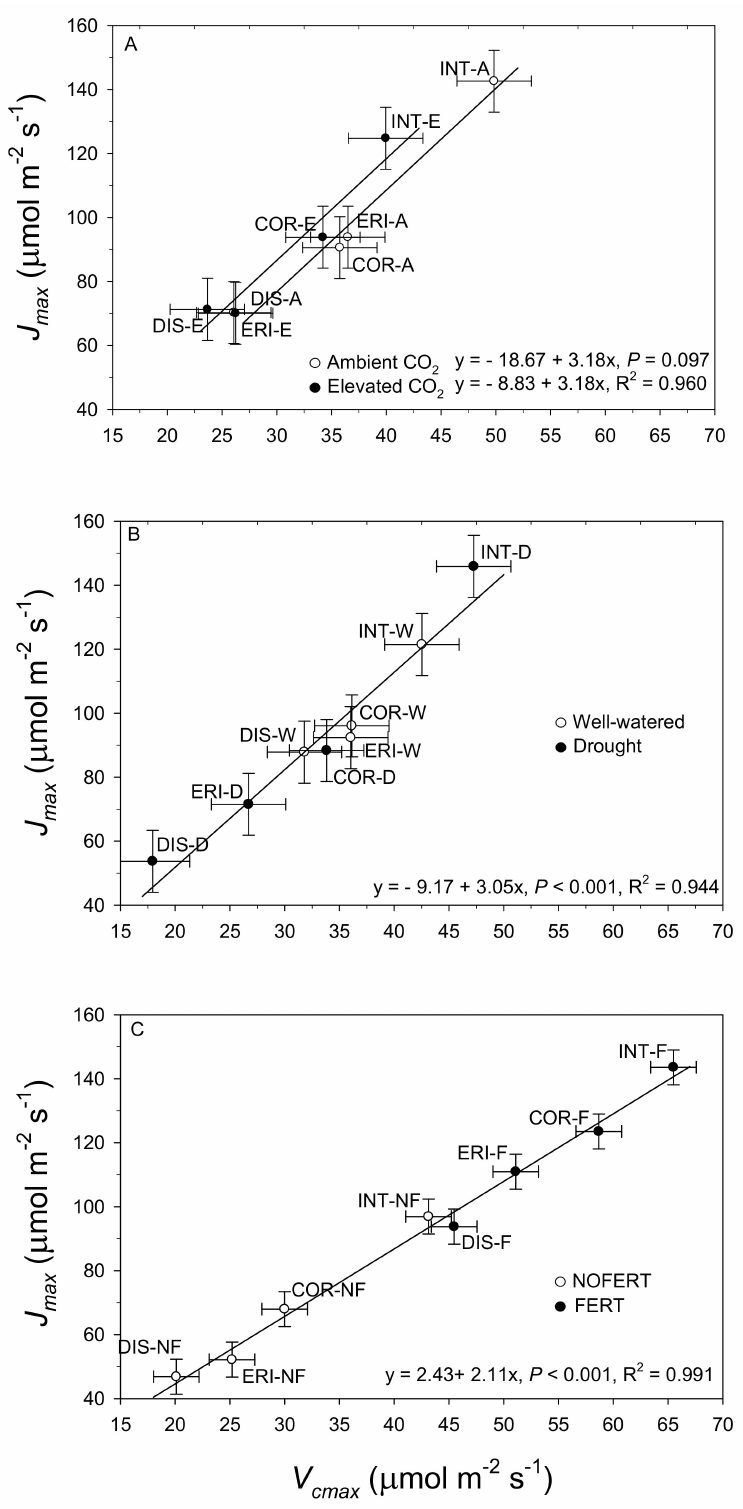
Figure 5. Relationship between maximum rate of electron transport ( J max ) and maximum rate of carboxylation ( V cmax ) across four willow species under ( A ) ambient and elevated CO 2 treatments, 2017, ( B ) well-watered and drought treatments, 2017, and ( C ) non fertilized and fertilized treatments,